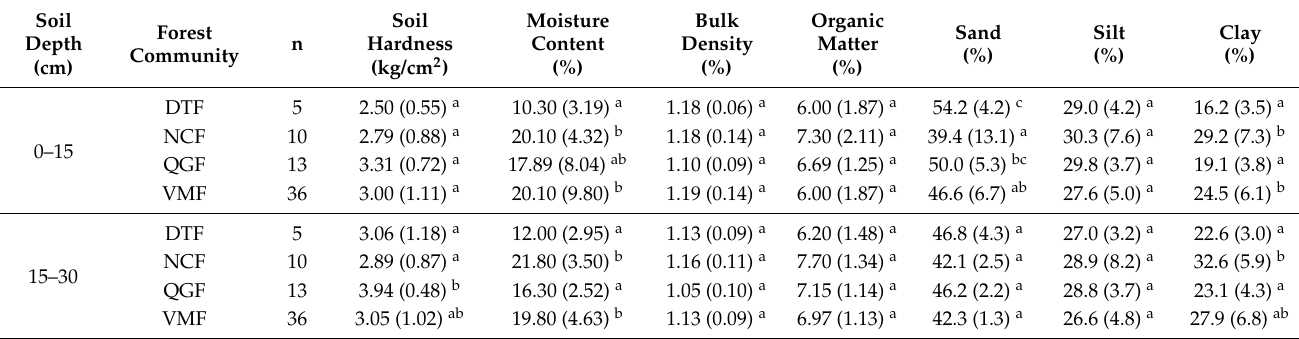
Table 3. Soil physical properties in the Diospyros toposia forest (DTF), Nothaphoebe condensa forest (NCF), Quercus glauca forest (QGF), and Vatica maingayi forest (VMF). Values in parenthesis are the standard deviations from the mean. Different lowercase letters indicate statistical significance between forest community types at α = 0.05. Values in parenthesis are the standard deviations from the